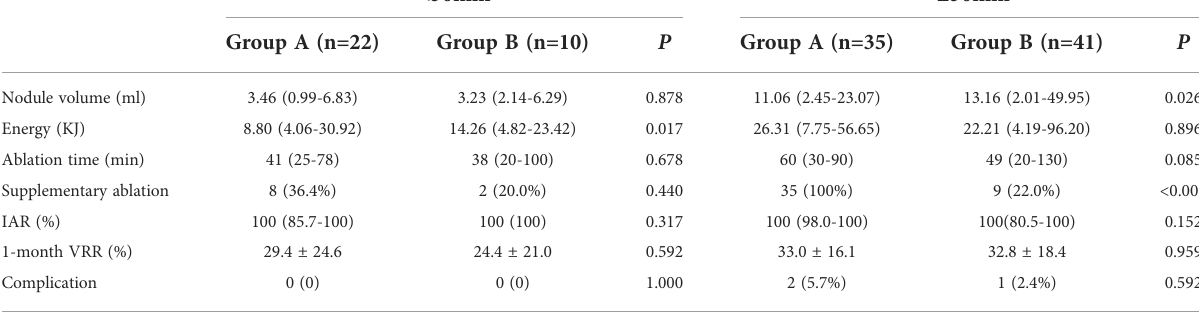
TABLE 2 Sub-groups analysis of treatment characteristics in different maximum nodule